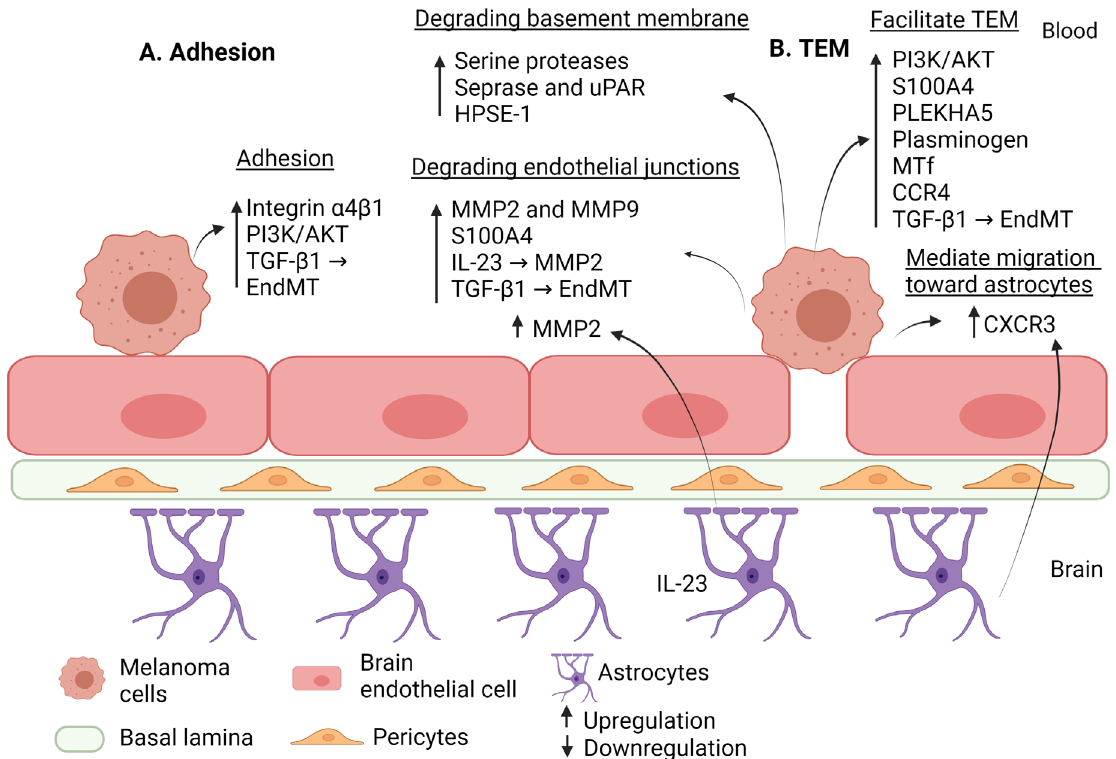
Figure 2. Schematic representation of extravasation steps in melanoma brain metastasis. ( A ) Rolling and firm adhesion: During adhesion to BE, melanoma cells express VLA-4(Integrin α 4 β 1), TGF- β1 (activate EndMT), and upregulate PI3K/AKT signaling pathway that enhance the adhesion of melanoma cells [74,75]. ( B ) Trans-endothelial migration: Disruption of endothelial junctions allows the TEM of melanoma cells. Melanoma cells release MMP2, MMP9, S100A4, and TGF- β1 that stimulates EndMT, which in turn reduces the expression of claudin-5 and VE-cadherin. Transmigrated melanoma cells trigger astrocytes to release IL-23, that in turn upregulates MMP2 in melanoma cells and facilitates TEM. Melanoma cells also release proteolytic enzymes to degrade a basement membrane, clude PI3K/AKT, S100A4, PLEKHA5, plasminogen, MTf, CCR4, and TGF- β1 that activate EndMT,